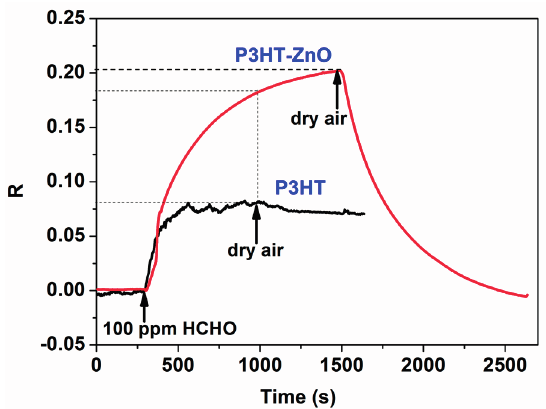
Figure 7. Real-time response curves of P3HT and P3HT-ZnO film OTFT sensors exposed to 100 ppm HCHO at room